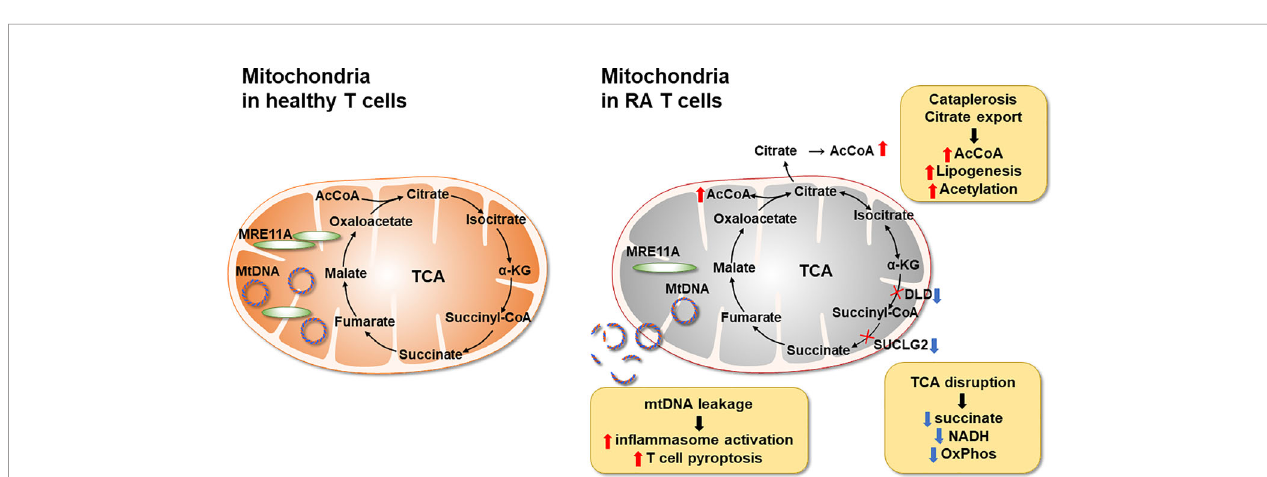
FIGURE 2 | In fl ammatory Macrophages in Rheumatoid Synovitis. Bone marrow-derived macrophages that in fi ltrate into the arthritic joint enter an oxygen lo , glucose lo , ROS hi , succinate hi , fatty acid hi , lactate hi tissue environment. Inactivation of glycogen synthase kinase 3 b (GSK-3 b ) in macrophages optimizes pyruvate import, enhancing mitochondrial activity. High oxidative phosphorylation increases ATP production and ROS release. ATP abundance promotes macrophage longevity. ROS facilitate the dimerization of the cytosolic enzyme pyruvate kinase M2 (PKM2), enabling nuclear translocation and STAT3 activation by the kinase. High mitochondrial activity supports the production of TNF a , IL-12, IL-23, IL-6 and IL-1 b . In fl ammatory macrophages trigger and sustain synovitis by modulating the function of neighboring T effector cells, endothelial cells, osteoclasts and synovial fi broblasts. NOX, NADPH oxidase; T eff , T effector cell.